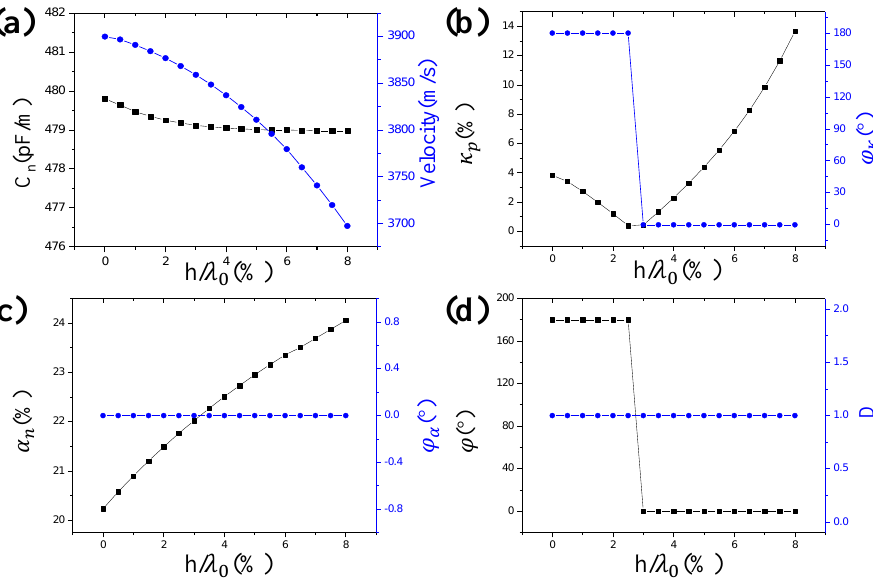
from Figure 6d that the unidirectional angle is offset by 180 ◦ when h/ λ 0 increases, and the directivity increases as h / λ 0 increases.